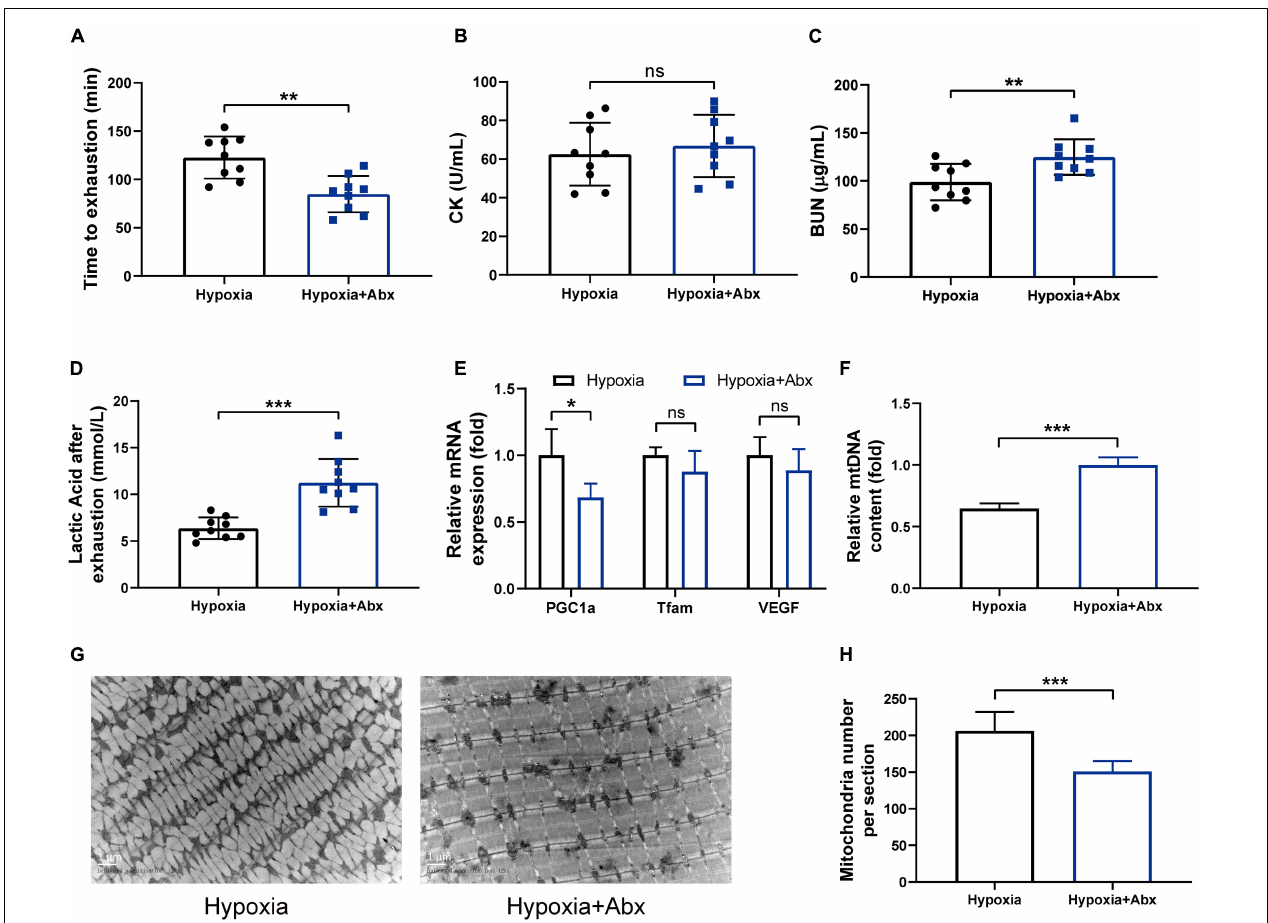
FIGURE 4 | Gut microbiota contributed to the beneficial effects of hypoxia on endurance performance. (A) Time until exhaustion was recorded. After exhaustion, CK (B) , BUN (C) , and lactic acid (D) were measured immediately. The expression of mitochondrial biogenesis (E) and the mtDNA content (F) were measured by RT-PCR. Representative TEM images (G) and quantification (H) of mitochondria in gastrocnemius muscle at original magnification of × 12,000. Data are presented as means ± SD. * p < 0.05, ** p < 0.01, *** p < 0.001 (Student’s t -test, ns, no